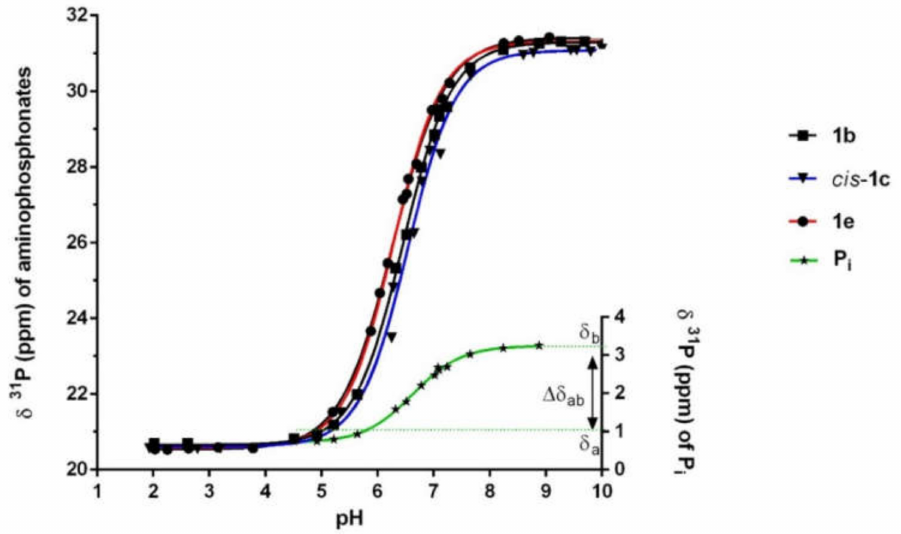
Figure 3. pH Dependence of the 31 P chemical shift of CyDEPMPHs 1b , cis - 1c , and 1e compared to P i . Titrations were performed at 22 ◦ C in a modified KH buffer (pH 7.35) and each curve was obtained by the nonlinear fitting of 3–10 independent experiments. Outlined: limiting acidic ( δ a ) and basic ( δ b ) chemical shifts, and their difference ( ∆ δ ab ) for P i